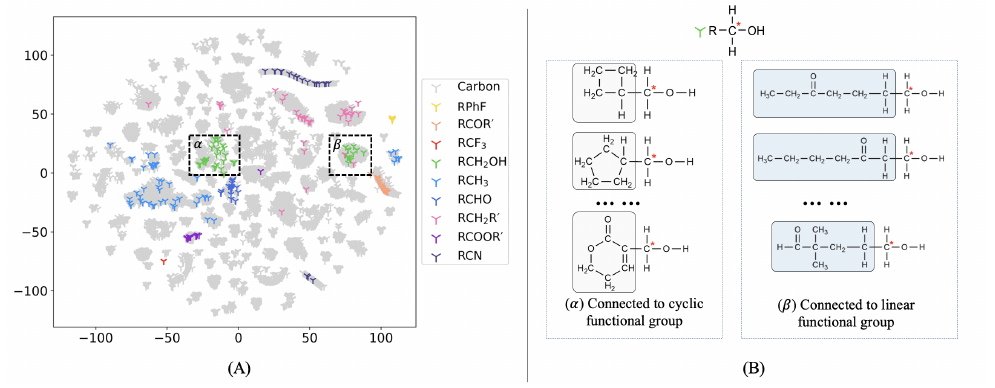
Figure 6. Node embeddings learned by MCM. ( A ): The t-SNE visualization of carbon representations learned by MCM. There are 30,000 carbons randomly sampled from the QM9 dataset. Among them, 300 are randomly chosen and are colored based on types of functional groups that carbons belong to, for example, alcohol(-OH) in green, three fluorines (F 3 ) in red, and so on. Both R and R’ are the abbreviations for groups in the rest of a molecule. The details of the nine local structure groups are listed in Table A4. The green group are separated into two sub-groups ( α and β ). ( B ): The carbons, whose representations visualized in the Left, are marked by red *. The carbons in the green group share the same one-hop local structures shown at the top. The two green sub-groups have distinct characteristics in their at-large local structures. In the α cluster, the marked carbons are connected to cyclic functional groups. In the β cluster, the marked carbons are connected to linear functional